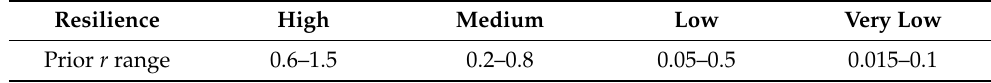
Table 2. Prior r ranges used for CMSY+.